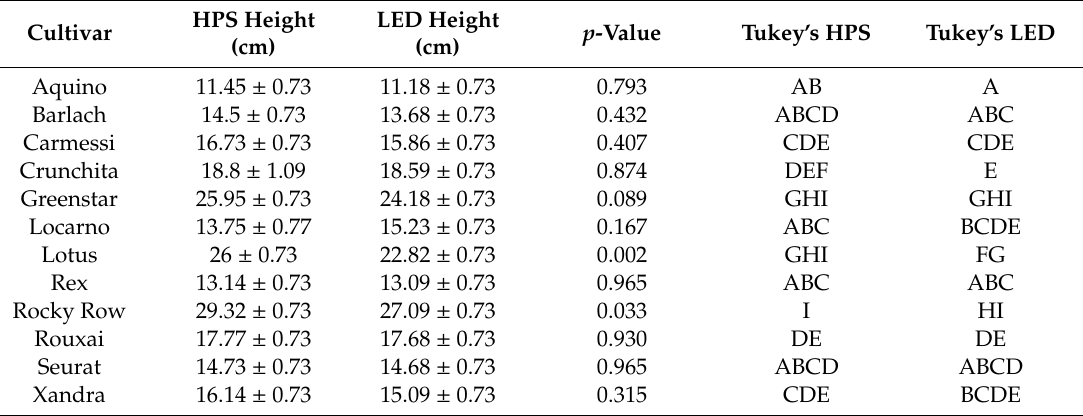
Table 7. Plant height (cm) of 13 cultivars of lettuce in phase 1, in which plants were grown